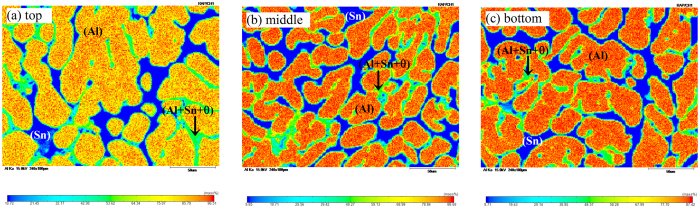
Uniform microstructures and solute distribution profiles of ternary Al71.9Sn20.4Cu7.7 alloy solidified within 3D ultrasounds analyzed by EPMA.A typical 240 × 180 μm area at (a) sample top; (b) middle part; (c) sample bottom.